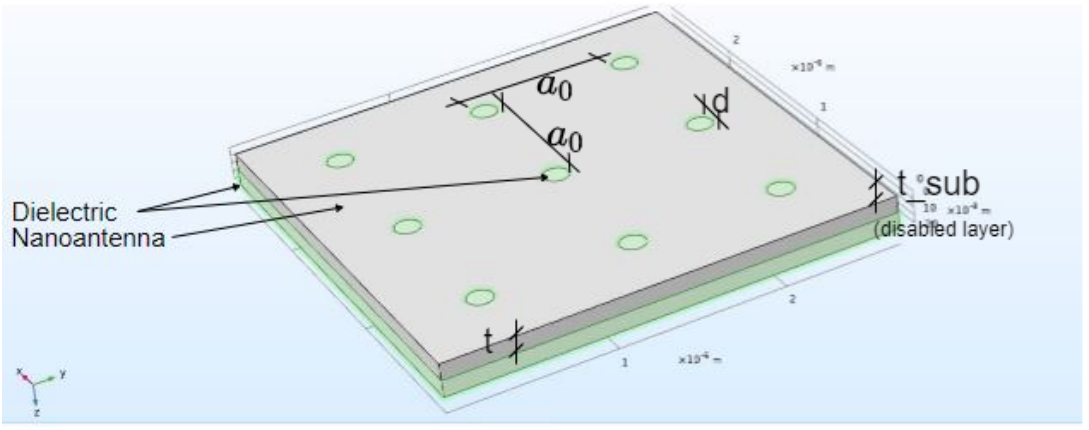
Figure 2. Structure illustration focusing on the